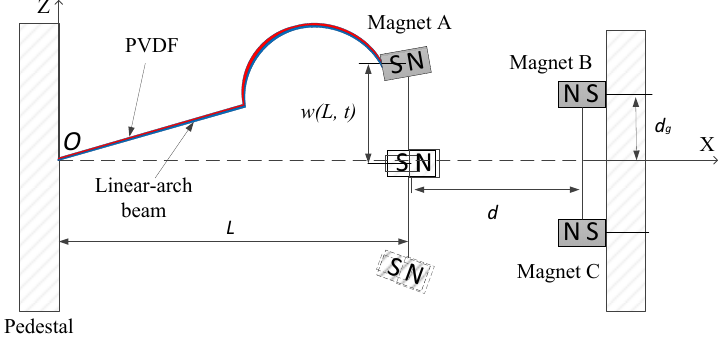
Figure 2. Schematic diagram of linear-arch beam TPEH.